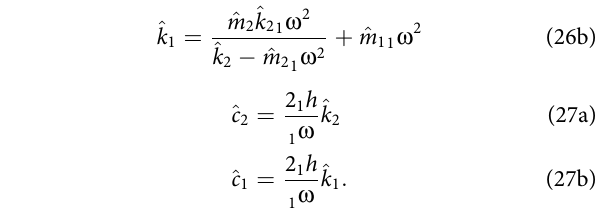
Frontiers in Built Environment |